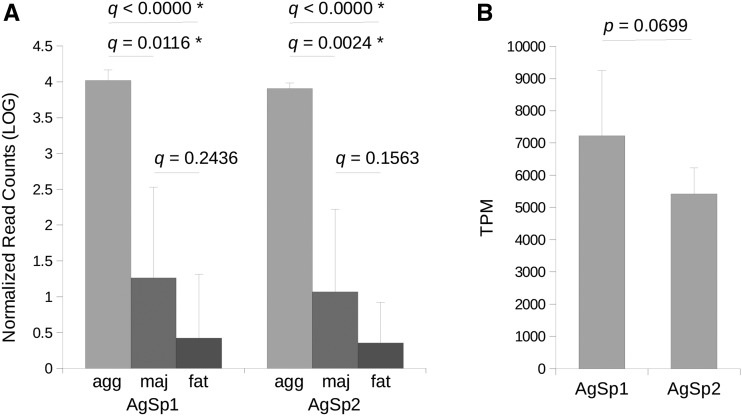
Gene expression analyses for AgSp1 and AgSp2 of A. trifasciata. Genes were each manually edited to 999 bp of the 3′ ends for analyses. (A) Log number of normalized reads that align to AgSp1 and AgSp2 from aggregate gland tissue (agg), major ampullate gland tissue (maj) and fat body tissue (fat). Line ends correspond to statistical comparisons between tissues. (B) Transcripts per million (TPM) for AgSp1 and AgSp2 averaged across six aggregate gland tissue samples. Asterisks indicate significant q- and p-values (<0.05).